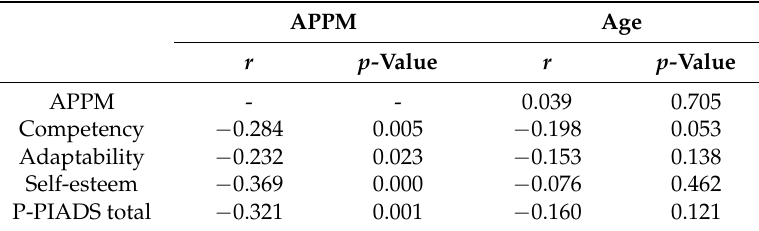
Table 2. Relation between APPM, age and P-PIADS ( n = 96).